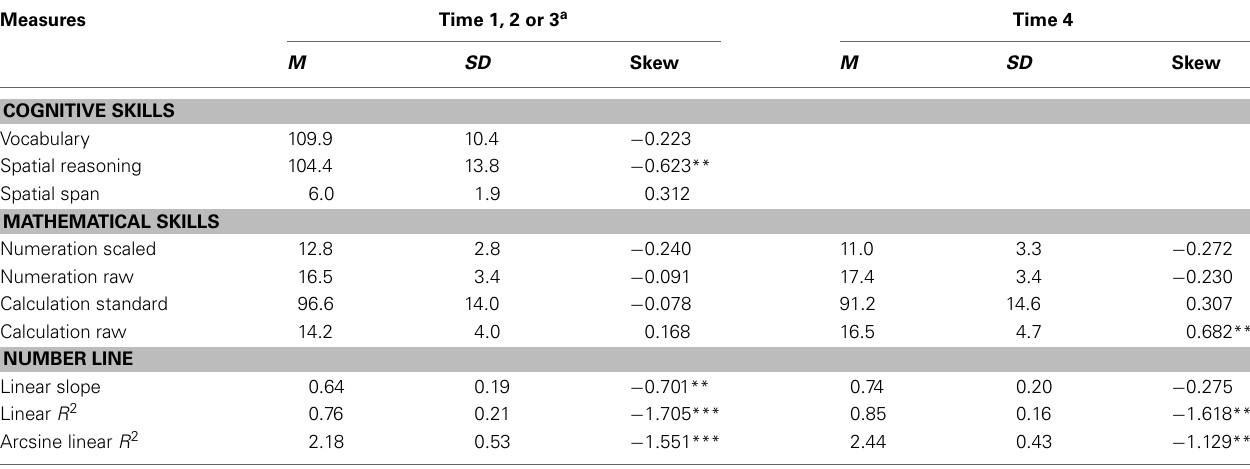
Table 1 | Descriptive statistics for predictor and outcome